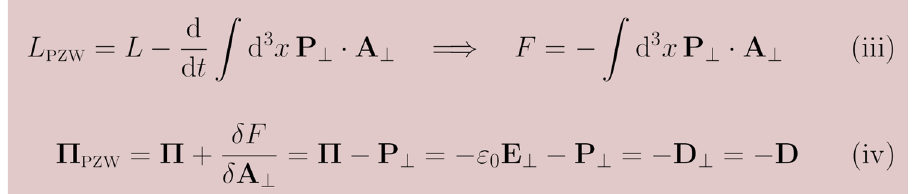
Figure 2. The change of conjugate momentum under the PZW transformation as derived from the general formula presented in Fig.